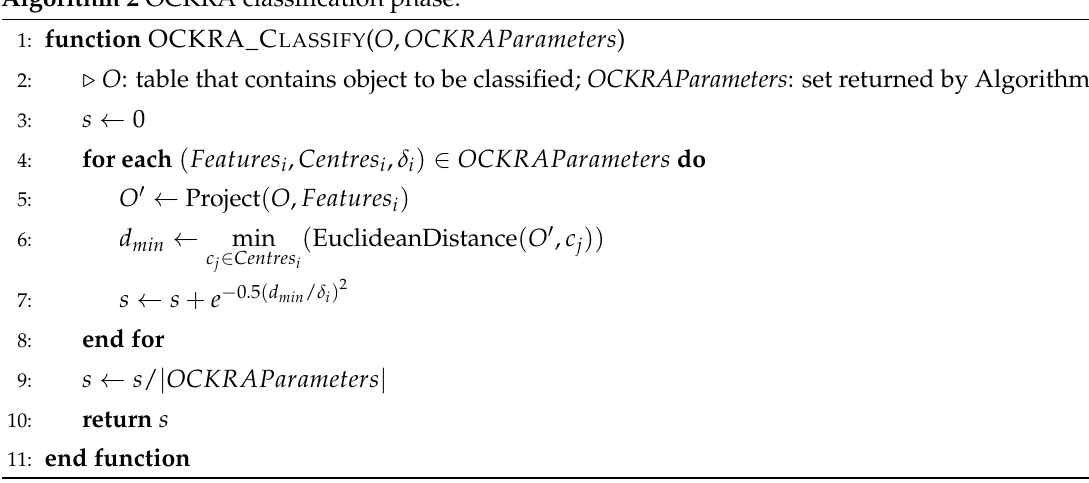
Algorithm 2 OCKRA classification